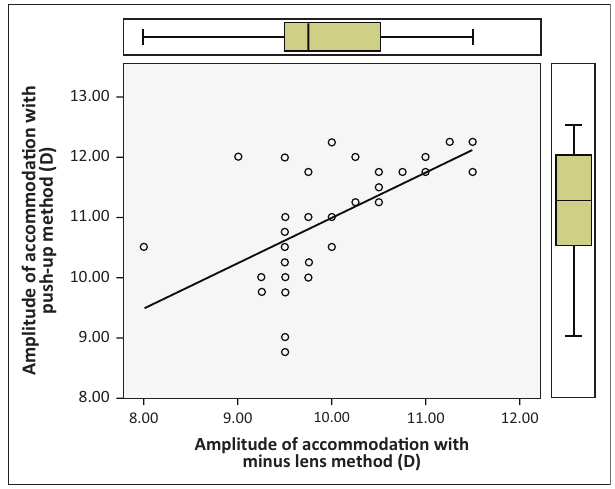
The correlation r = 0.60. The regression line: y = 3.5 + 0.75x. FIGURE 4: Correlation of the amplitude of accommodation measured using the push-up method versus the amplitude of accommodation measured using the minus lens method to